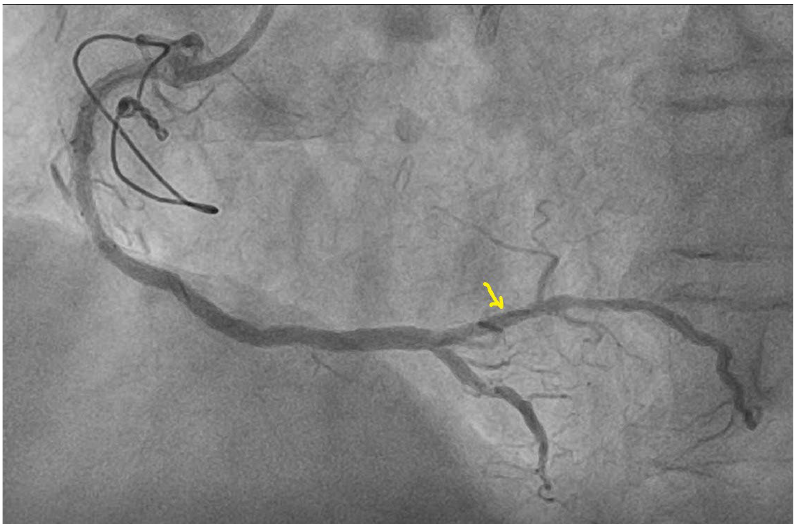
Figure 6. Coronary angiography post dilatation and stent implantation in the postero-lateral branch of the right coronary artery (arrow).